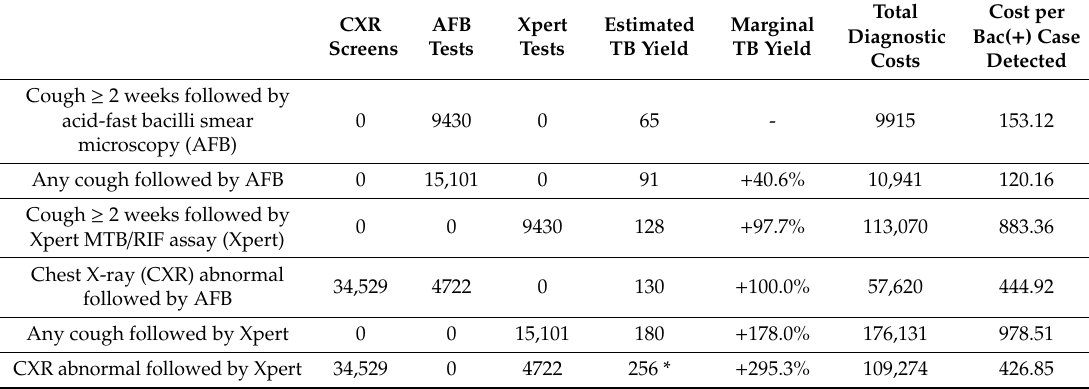
Table 2. Marginal yields of TB from various diagnostic algorithms and their relative diagnostic costs